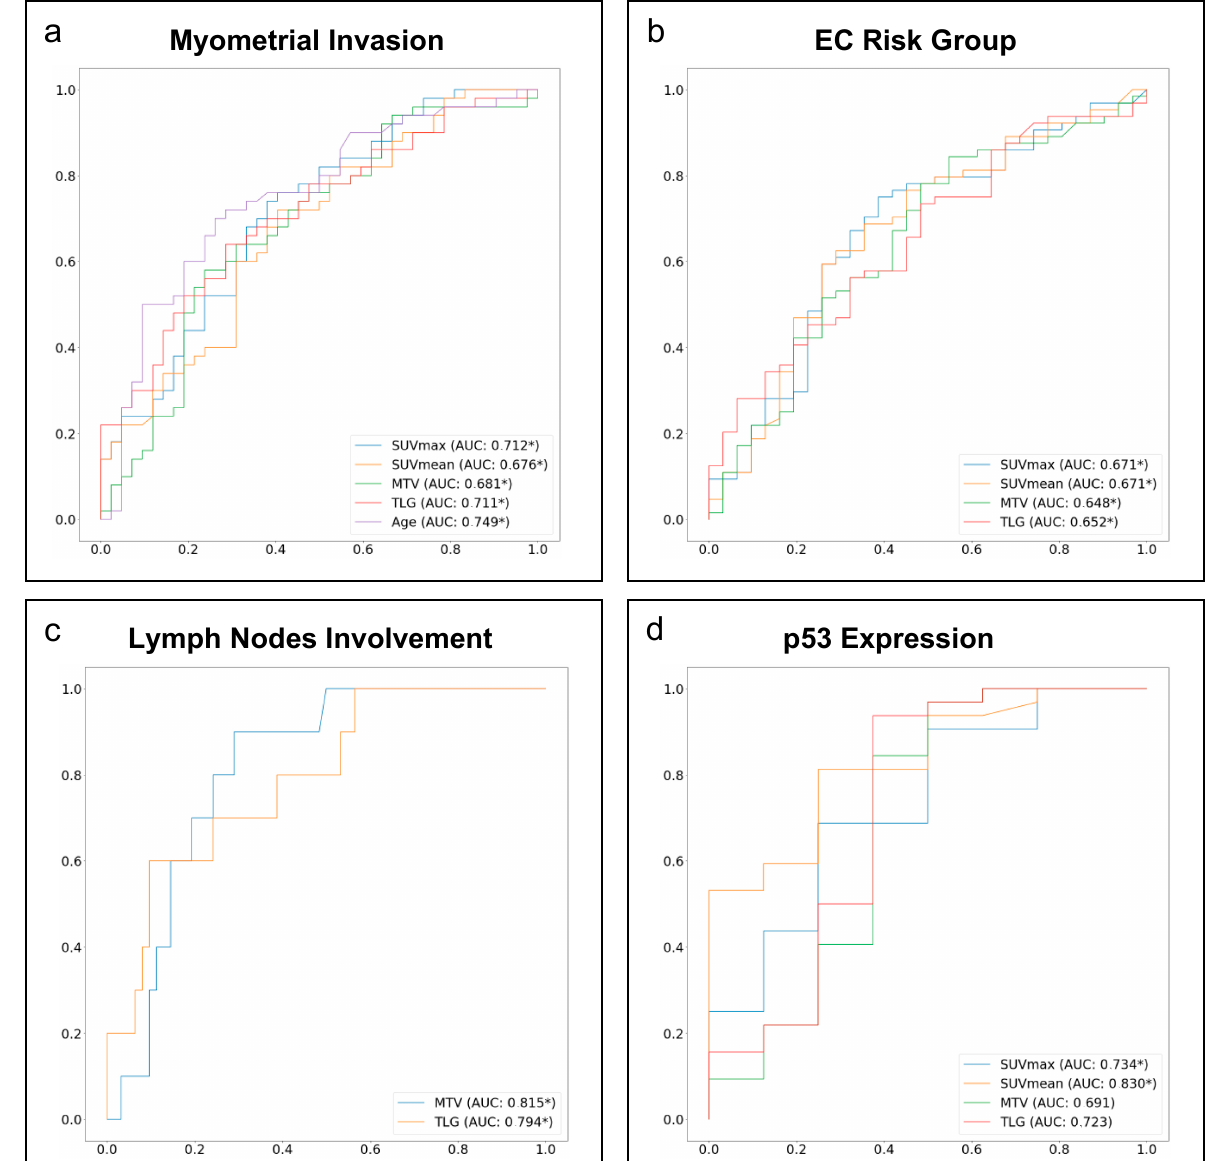
Figure 2. ROC curves of 18 F–FDG PET and clinical parameters as predictors of the different features of EC aggressiveness. Solid lines represent the area under the curve (AUC) obtained for SUVmax (light blue). SUVmean (orange). MTV (green). TLG (red) and age (purple) in predicting: ( a ) presence of deep myometrial invasion (>50%); ( b ) risk group classification; ( c ) presence of lymph nodes involvement; ( d ) p53 expression. AUC values coupled with a statistically significant 95% confidence interval are marked with *. SUV = standardized uptake value; MTV = metabolic tumour volume; TLG = total lesion glycolysis.